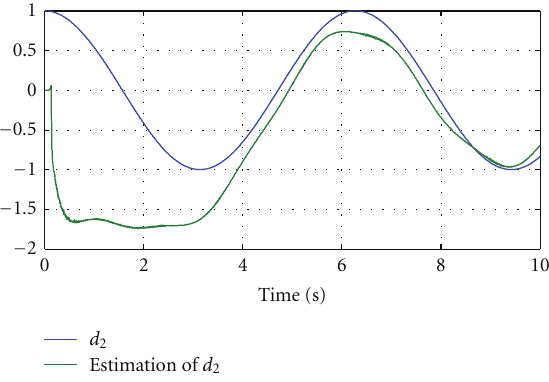
Figure 10: True and estimation values of d 2 for Example